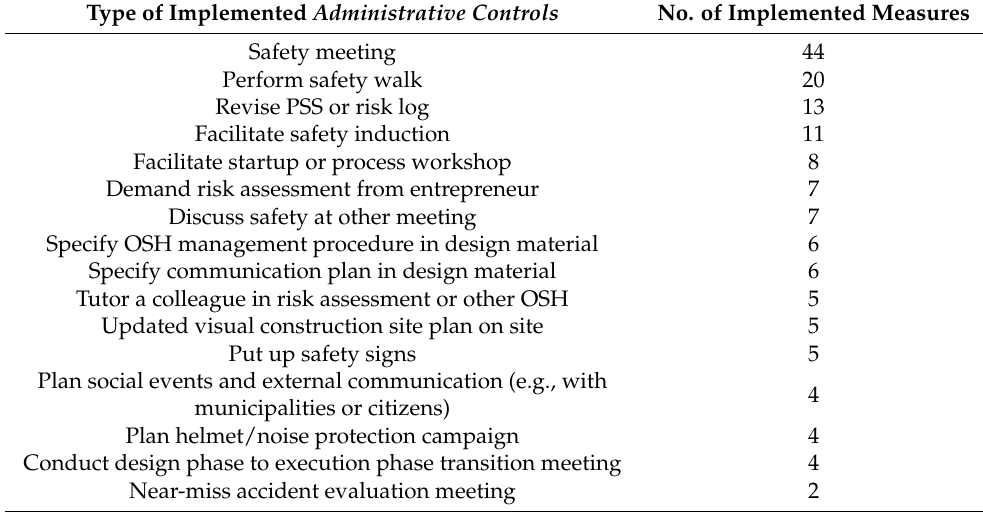
Table 3. Subcategories of successfully implemented administrative controls .